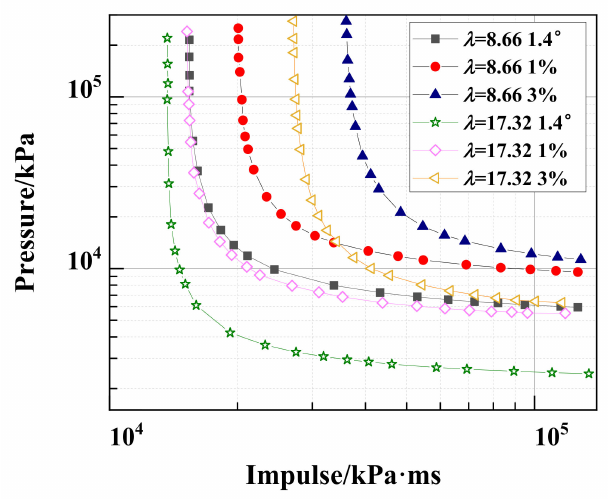
Figure 11. Analysis of P-I curves with two slenderness ratios, 8.66 and